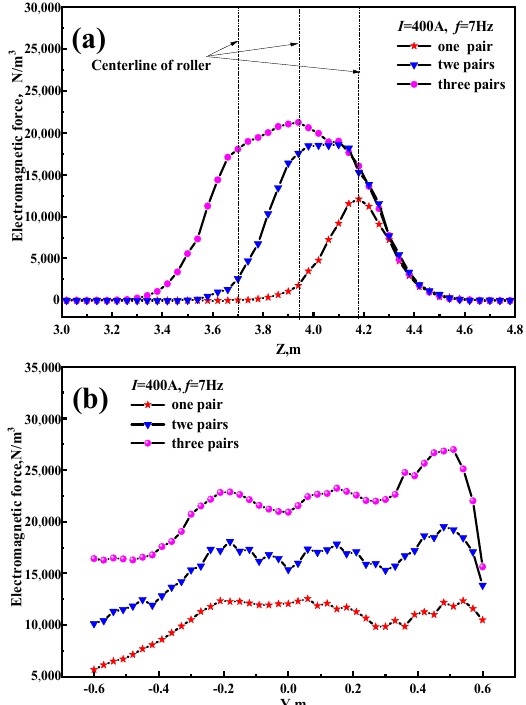
Figure 7 . Distribution of internal electromagnetic force in the strand with different number of roll- ers ( a ) along the centerline in the casting direction, ( b ) along the centerline of the rollers in the wide direction.